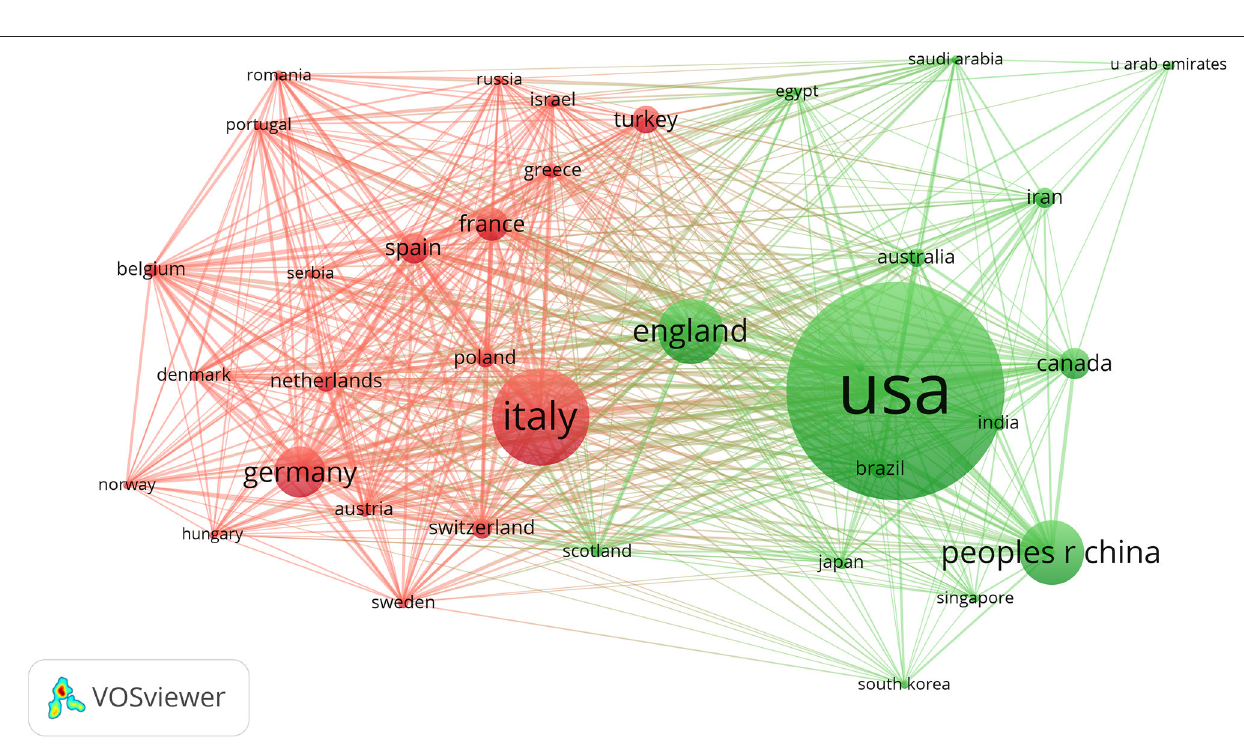
FIGURE 2 | The detailed information of country distribution. The terms were represented by nodes, while links (lines) connected the nodes. The size of the circle was proportional to its number of publications, while the width of the line between the two items was related to the magnitude of their collaboration. Items of the same color belonged to the same cluster, indicating that they cooperated closely in this field. The more clusters there were, the more decentralized the cooperation was. The USA, Italy, and England were the top three countries that published the most articles. They were mainly divided into two clusters as shown in this figure. Cluster 1 included the USA, China, England, Canada, and Australia. Cluster 2 included Italy, German, France, Spain, Greece, and Turkey.